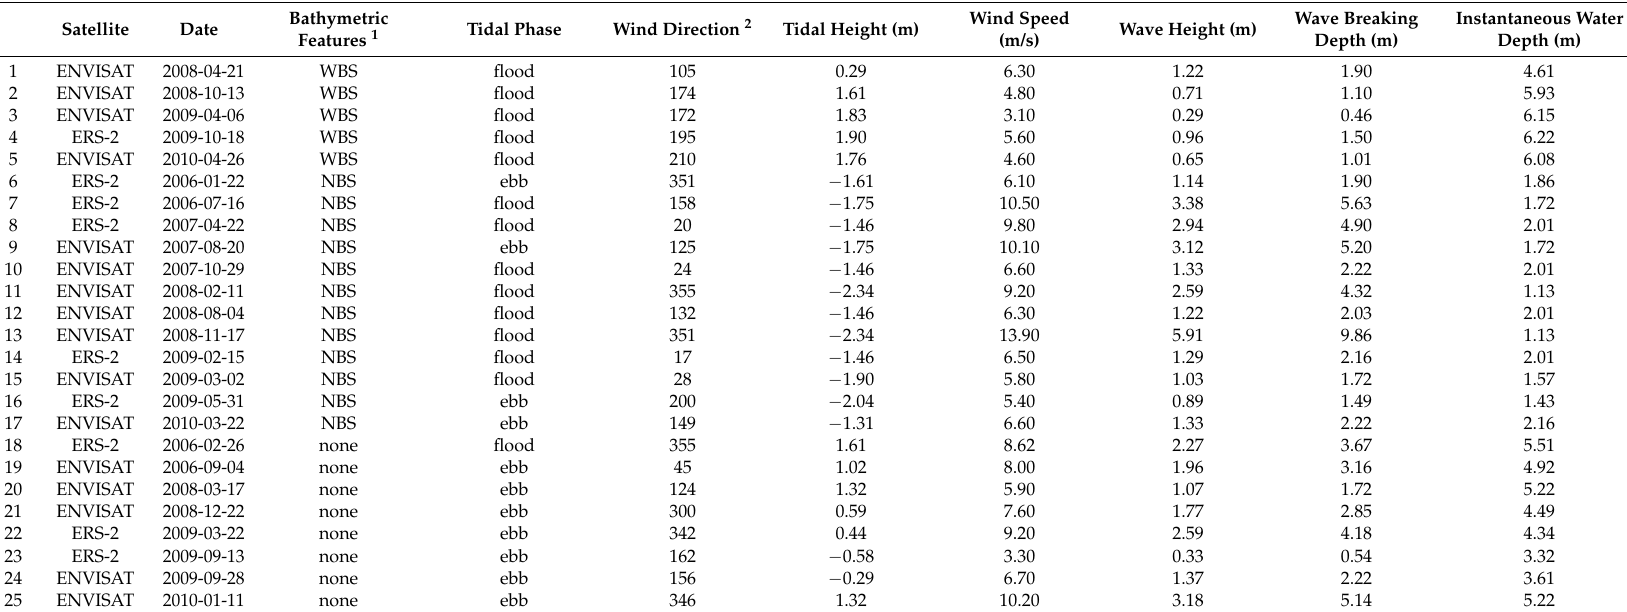
Table 1. Wind, current, and tide conditions at an imaging time of 25 SAR